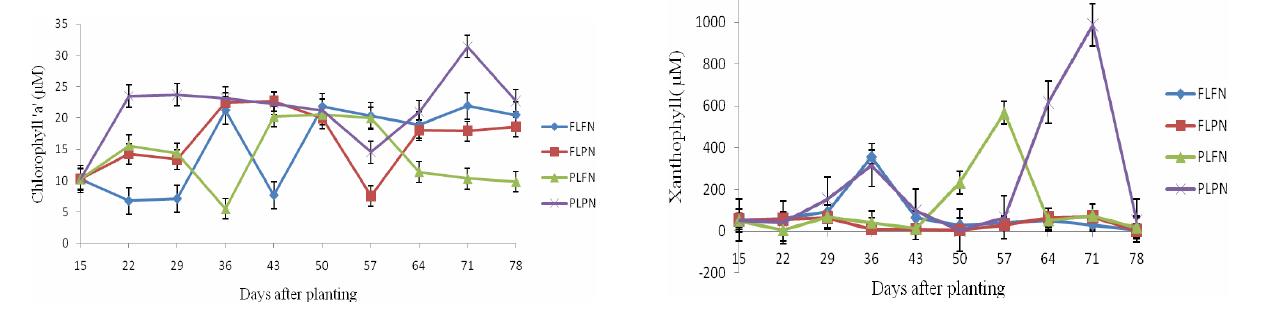
Fig. 8. Effect of light and nutrient stress on the xanthophyll